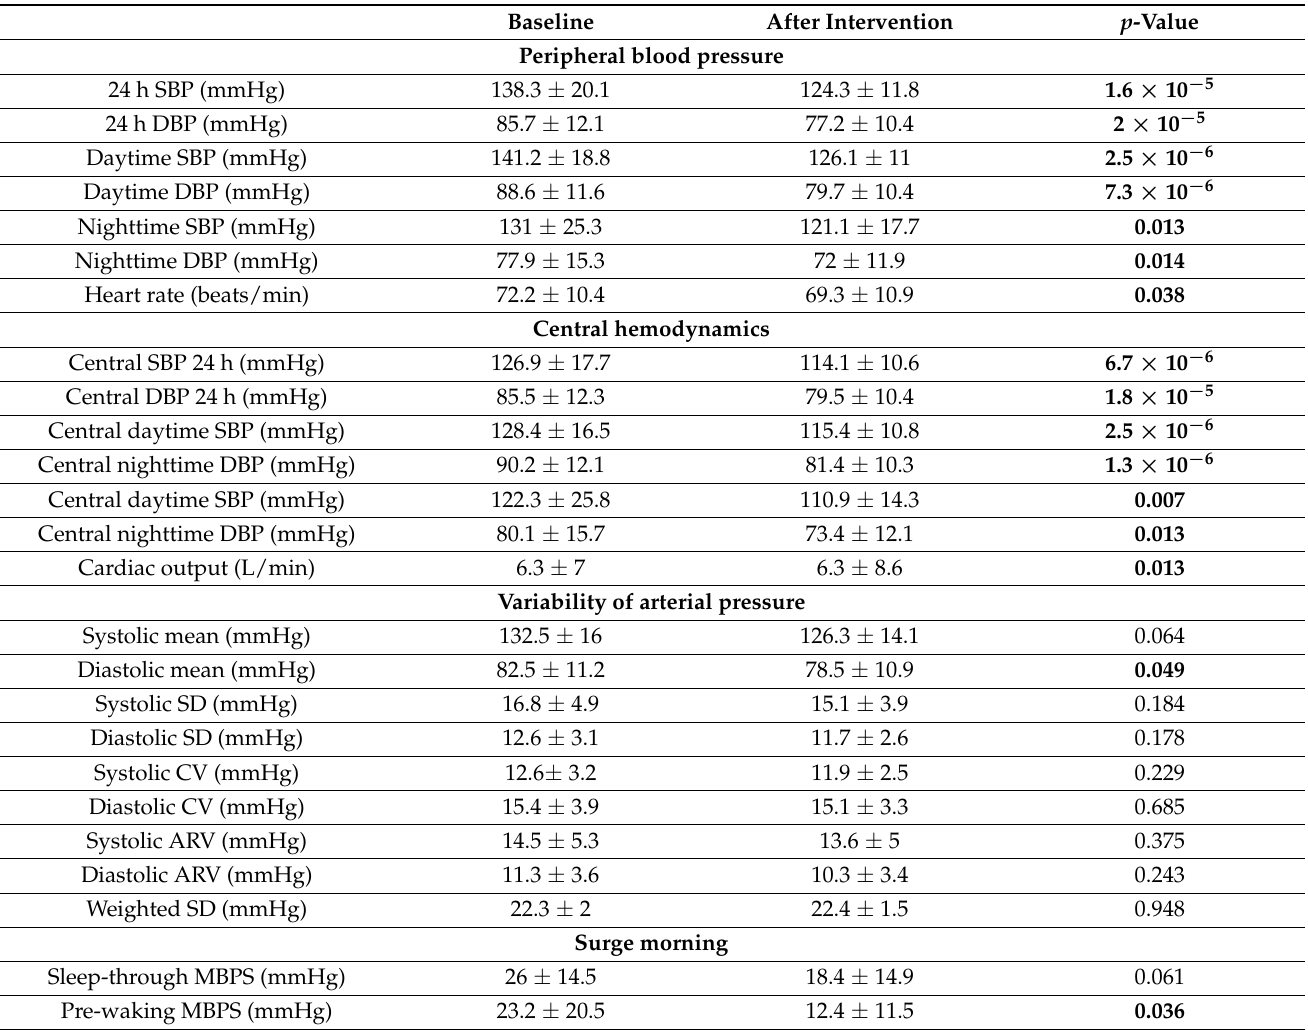
Table 2. Mean changes in ambulatory blood pressure and calculated